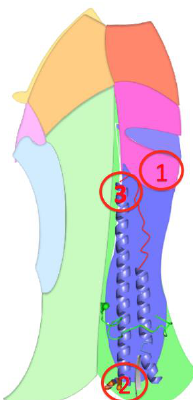
Figure 8. Potential targets and HA functions. This HA scheme describes the three subunits of the protein (3 different shades of the same color to differentiate subunits; if there are only two shades, this means that the third subunit is not visible in the 2D projection of the 3D structure) and its various protein domains. The receptor binding domain borne by HA1 is in orange. Vestigial esterase, the field carried by HA1 is pink. The F fusion domain borne by HA1 is in blue. The F fusion domain borne by HA2 is in green. The subdomains F’ and F form the fusion domain. Some important parts to understand the fusion process are also noted: the green loop is the fusion peptide located at the N-terminus of HA2, the residue at the C-terminus of HA2 is orange and the beta-sheet at the N-terminus of HA1 is gray. The B-loop is red. The alpha helices of HA2 are blue. The three potential targets are designated 1, 2, and 3 in red circles and are depicted only on one subunit for